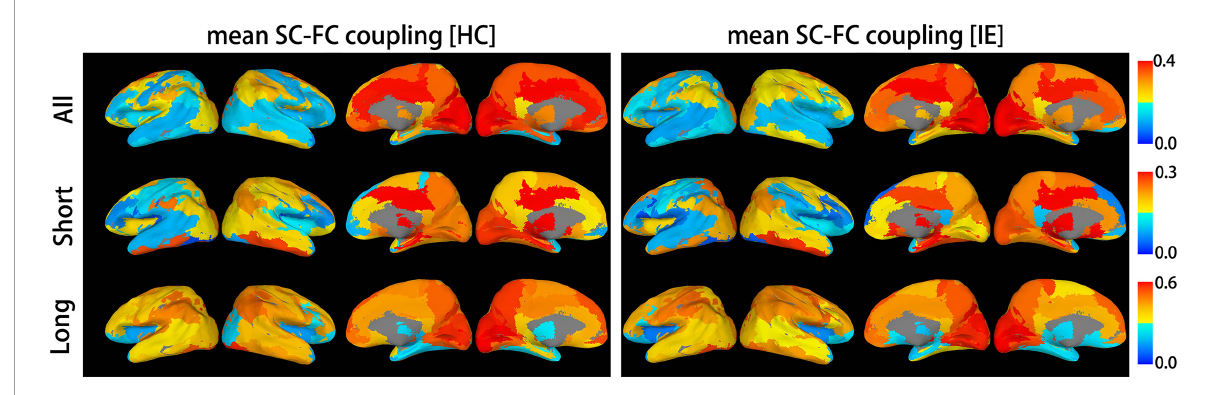
FIGURE2 Mean structural-functional connectivity coupling score of each brain subregion. The graphic presents mean coupling score for whole brain connections, long-distance connections and short-distance connections of each brain subregion in patients with infantile esotropia and healthy subjects. SC, structural connectivity; FC, functional connectivity; HC, healthy control; IE, infantile esotropia.